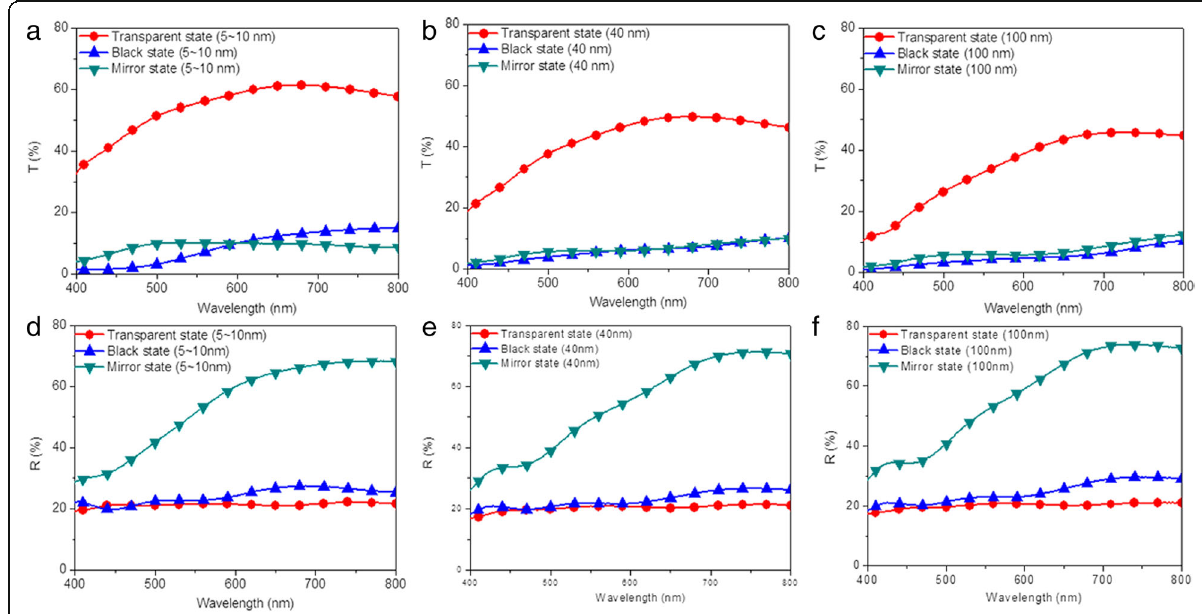
Fig. 1 (Color online) Optical properties of the electrodeposition-based electrochromic device in transparent ( red ), black ( blue ), and mirror states ( green ). Transmittance spectra of modified devices prepared with a 5~10, b 40, and c 100 nm, respectively. Reflectance spectra of modified devices prepared with d 5~10, e 40, and f 100 nm,